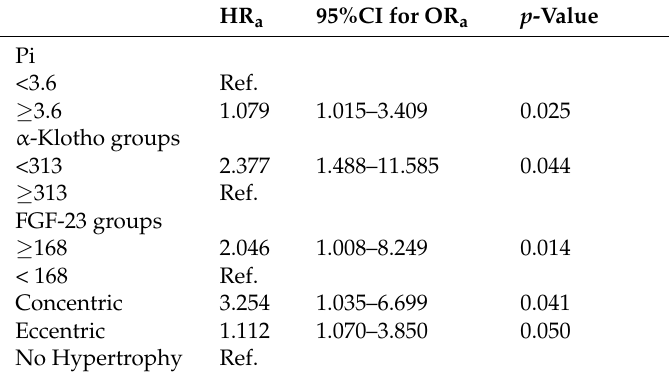
Table 6. Factors independently associated with cardiovascular